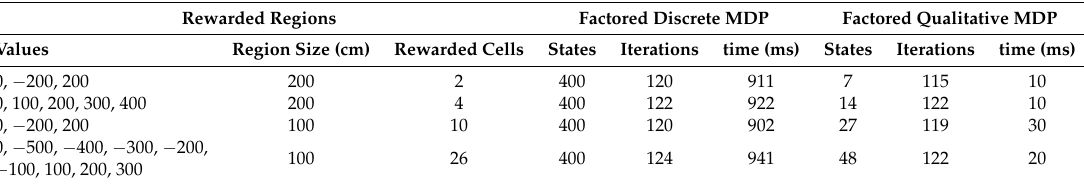
Table 4. Comparison of abstraction-refinement methods versus a discrete factored MDP under different problem